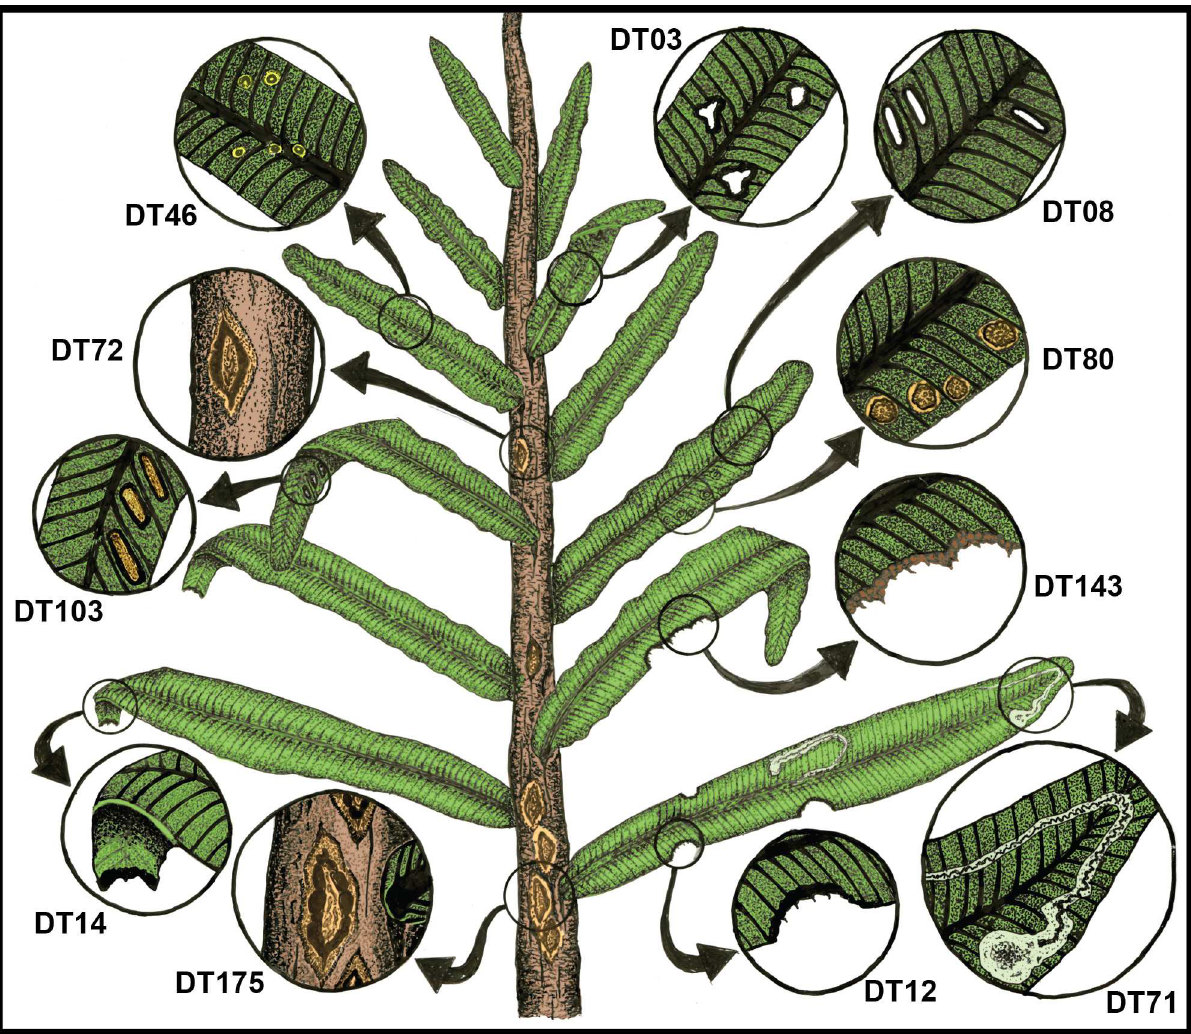
Fig 13. The insect herbivore component community of pteridosperm Scytophyllum bergeri , from the Middle Triassic (Anisian) Furkelpass floras of northeastern Italy. Eleven DTs are represented on this host plant, includingcounterclockwise from the upper left: piercingand sucking of DT46 (Fig 7K); single-eggoviposition of DT72 (Fig 7I); surface feedingof DT103 (Fig 7M), a related DT also recordedas DT82 in Fig 9G; margin feeding on pinnuleapices of DT14 (Figs 7A, 7B, 7D, 7J and 9E); multiple-egg oviposition of DT175 (Fig 7L); single pinnular margin feeding of DT12 (Figs 7F, 7J, 9E, 9F and 9I); leaf mining of DT71 (Fig 7N), also shown in Fig 9H as DT41; continuouspinnularmargin feedingof DT143 (Fig 7C–7E); gallingof DT80 (not Figd); slot hole feedingof DT08 (Fig 7G and 7H); and polylobatehole feeding of DT03 (not Figd). Herbivoreinsect culprits for these DTs likely were ovipositing odonatans (DT72, DT175), orthopterans(DT12, DT14, DT143), thysanopterans (DT46), sternorrhynchan and heteropteran hemipterans(DT46, DT80), chresmodids (DT72, DT175) tenthredinoid sawflies (DT80, DT143) and polyphaganbeetles (DT03, DT08, DT103, DT71) [9,55,57]. Possible predators on the herbivoreswere odonatans, dermapterans, neuropterans, and adephagan and polyphaganbeetles. Note that the herbivore feeding-guild diversity on S . bergeri is about three times of that on Late Permian Pseudovoltzia liebeana